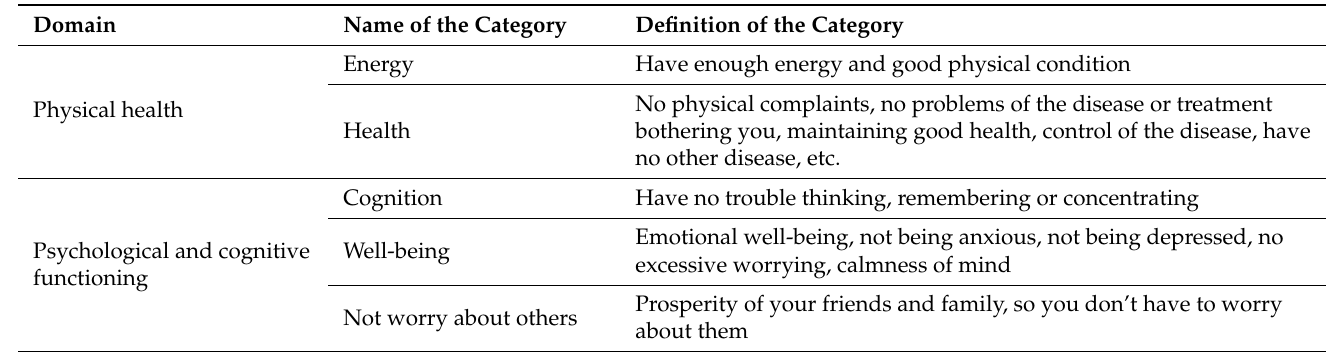
Table 1. Domains, categories and definitions. The following categories are made to classify the open-ended